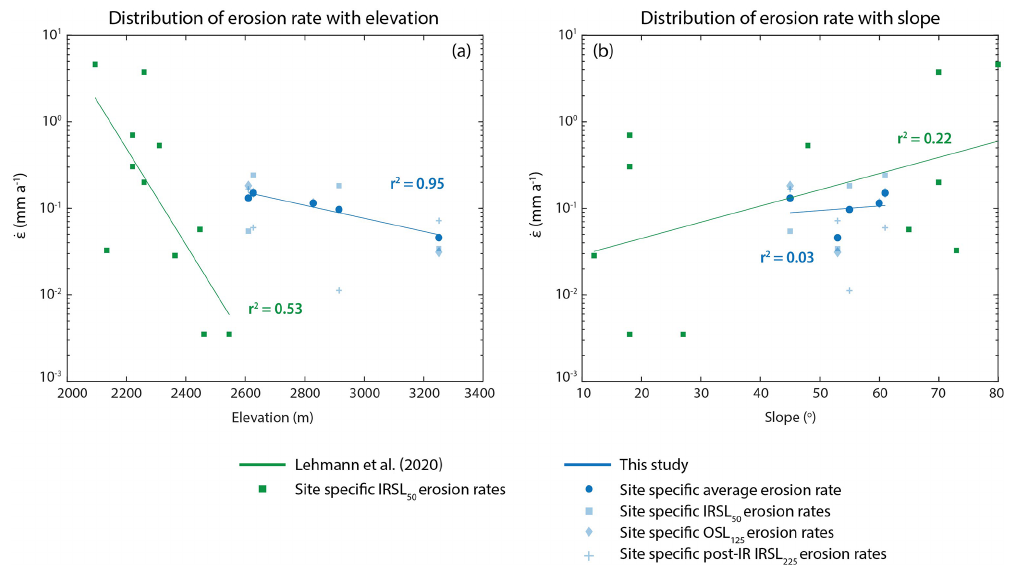
Figure 5. Distribution of inverted bedrock surface erosion rates ˙ ε with elevation (a) and surface slope (b) . The samples presented in this study are shown in blue (dark blue is the average values, light blue is the individual values from all three luminescence signals) alongside results from a nearby study at the Mont Blanc Massif in green (Lehmann et al.,